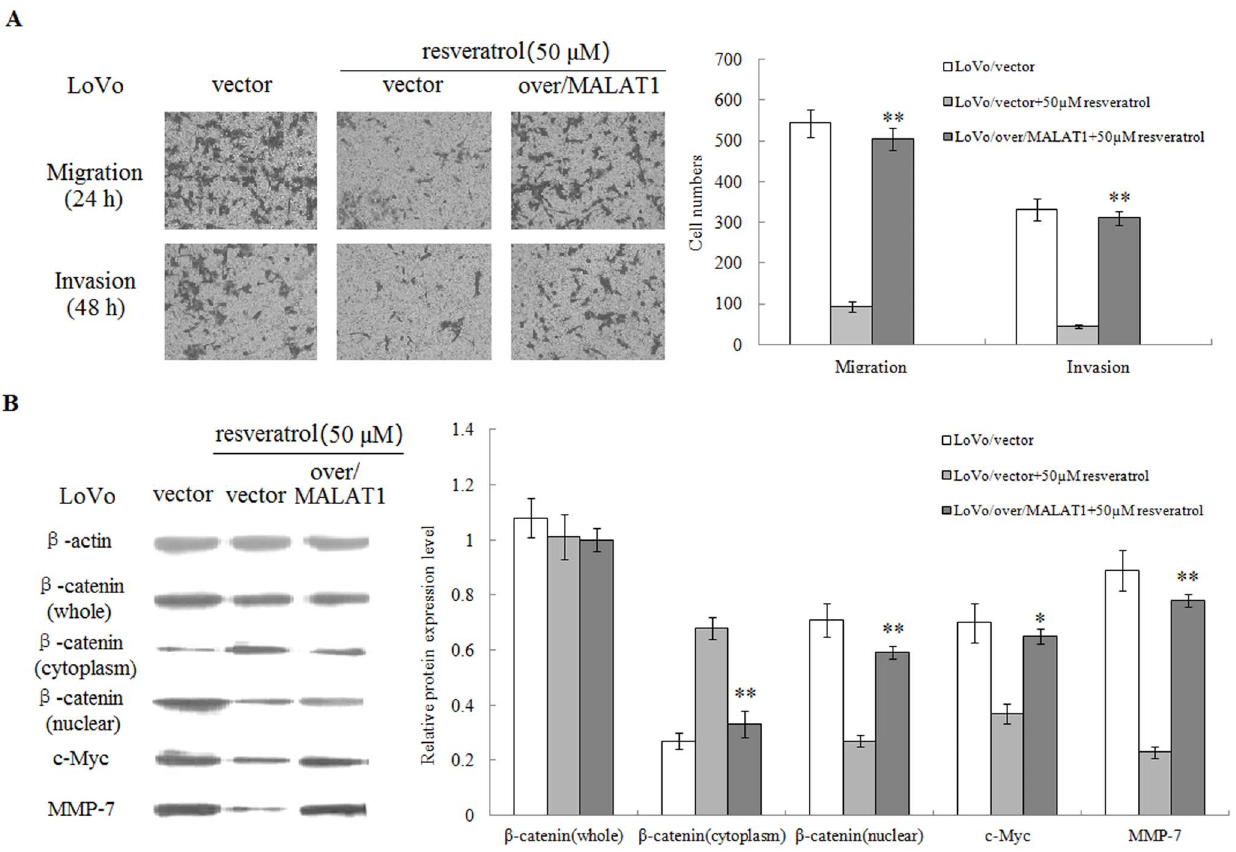
Figure 6. Overexpression of MALAT1 attenuates the suppressive effect of resveratrol on migration and invasion in LoVo cells. (A): LoVo cells expressing MALAT1-overexpressed, empty vector were treated with or without 50 m M resveratrol for 48 hours and cellular migration and invasion ability were measured. (B): Whole or cell extracts of different cellular compartments from LoVo cells expressing MALAT1-overexpressed, empty vector treated with or without 50 m M resveratrol were probed for b -catenin, c-Myc, MMP-7, and the protein levels were quantified. * p , 0.05 or ** p , 0.01, compared with LoVo cells treated with 50 m M resveratrol.